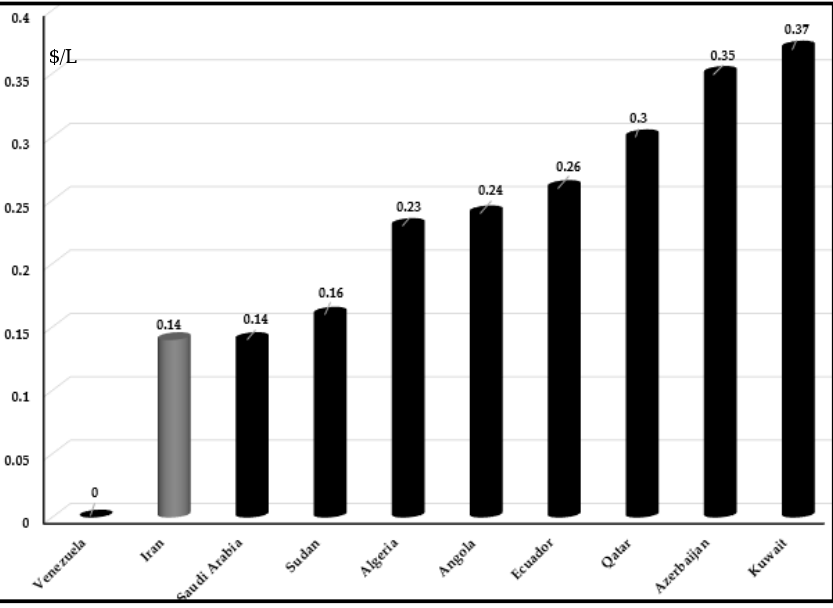
30 Figure 8. Response of LCO 2 to LGDP using structural VAR factor. According to Figure 8, a positive standard deviation shock to LGDP increases LCO 2 emissions over time. This result could be attributed to the low energy price (as stated before), which increases the energy intensity (Figure 9).